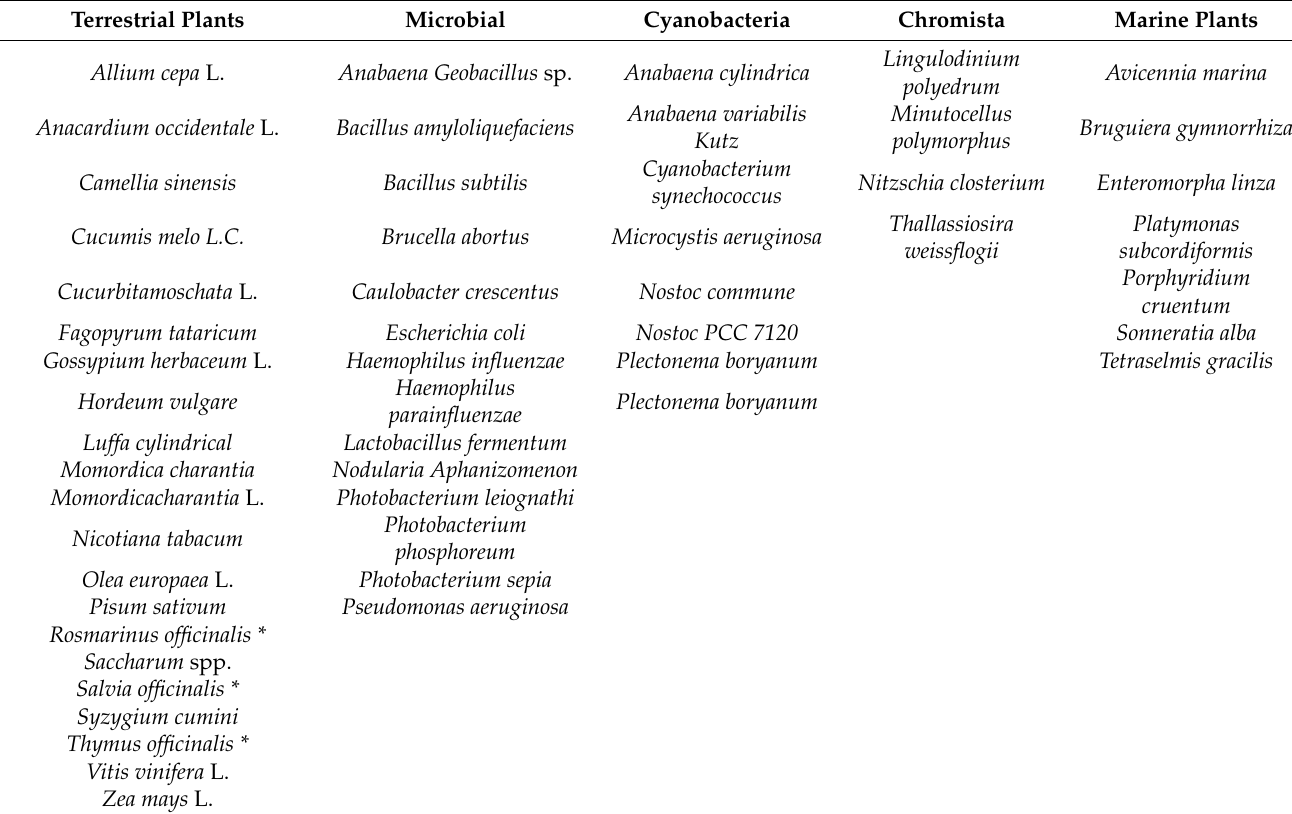
Table 4. Examples of major exogenous natural SOD